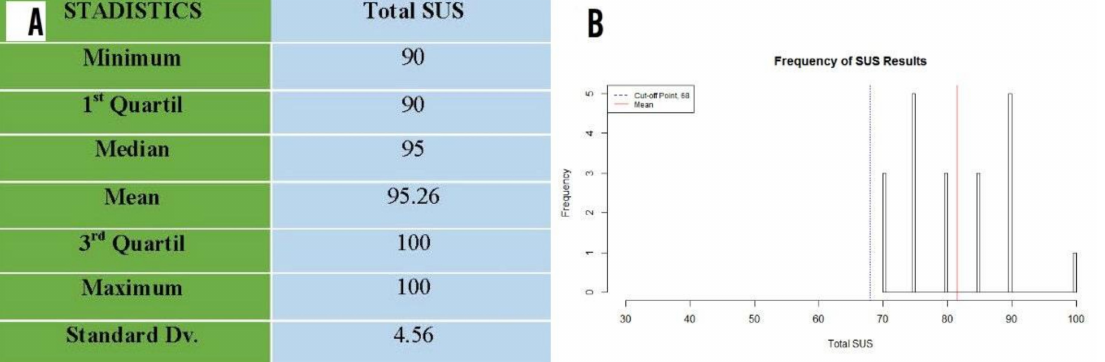
Figure 14. ( A ) Statistical description of the software usability scale (SUS) for study group. ( B ) Histogram of results obtained using the software usability scale (SUS); red line: mean; blue line represents cut-off point.